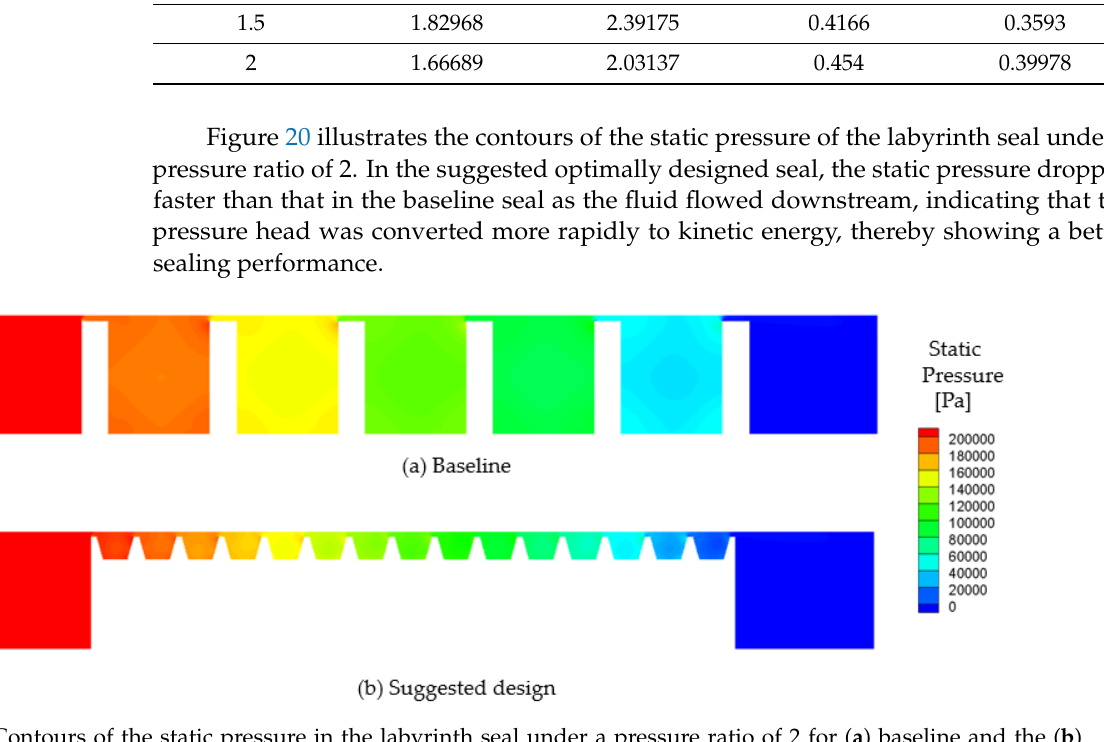
Figure 20. Contours of the static pressure in the labyrinth seal under a pressure ratio of 2 for ( a ) baseline and the ( b ) suggested design. Table 6. Jet divergence angle and discharge coefficients for the baseline and suggested optimal geometry for a labyrinth seal under pressure ratios of 1.1, 1.5, and 2.